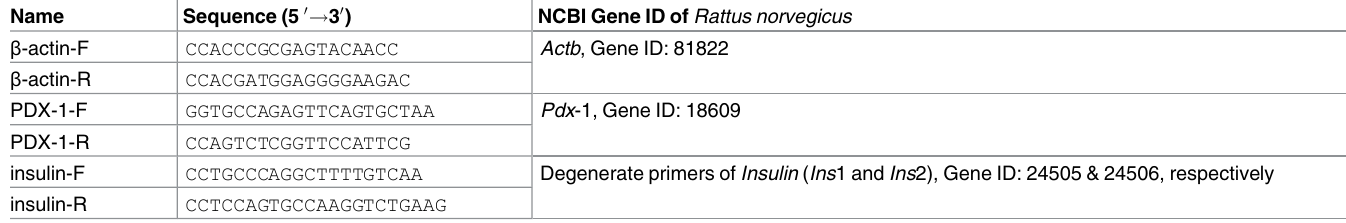
Table 2. Primers used in this